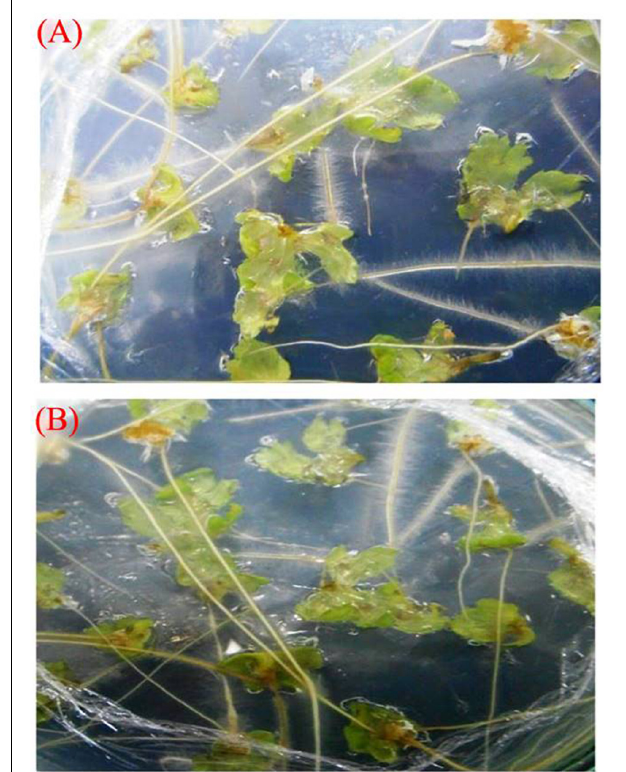
FIGURE 5 | (A) After 2 weeks of coculture of A 4 strain on hairy root initiation from leaf explants cultured on MS + 500 mg/L cefotaxime medium. (B) After 2 weeks of coculture of R 1000 strain on hairy root initiation from leaf explants cultured on MS + 500 mg/L cefotaxime